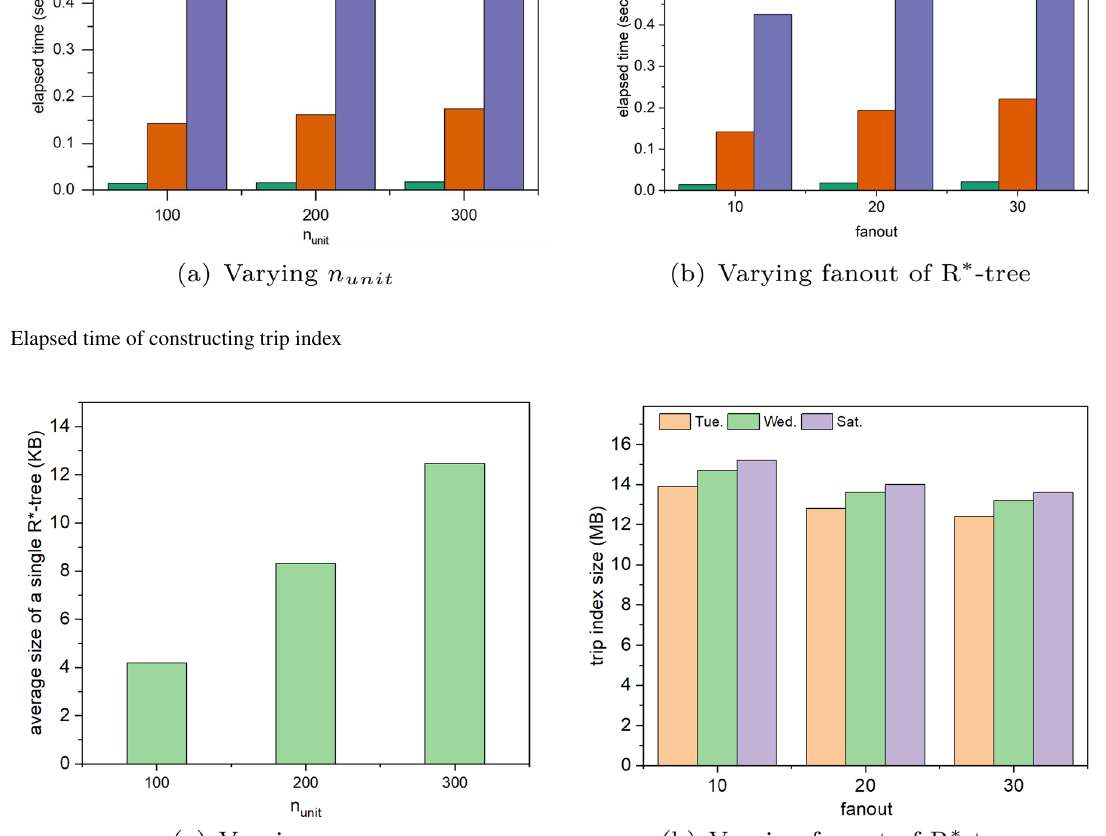
Algorithm 6 introduces the procedure of merging cells.